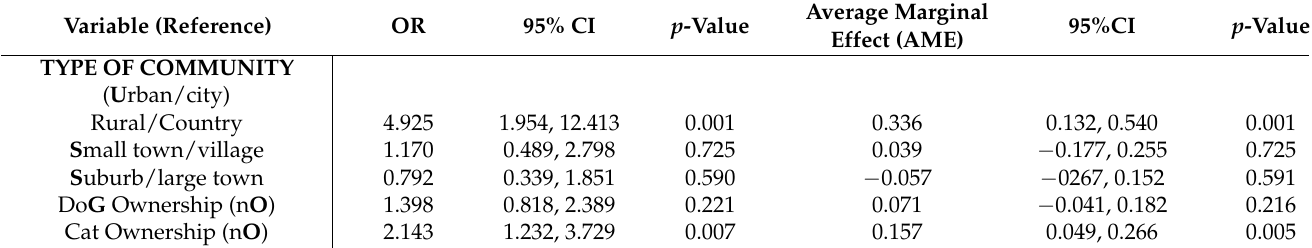
Table 2. Odds of a diagnosis with Lyme disease by demographic risk factors, controlling for age and